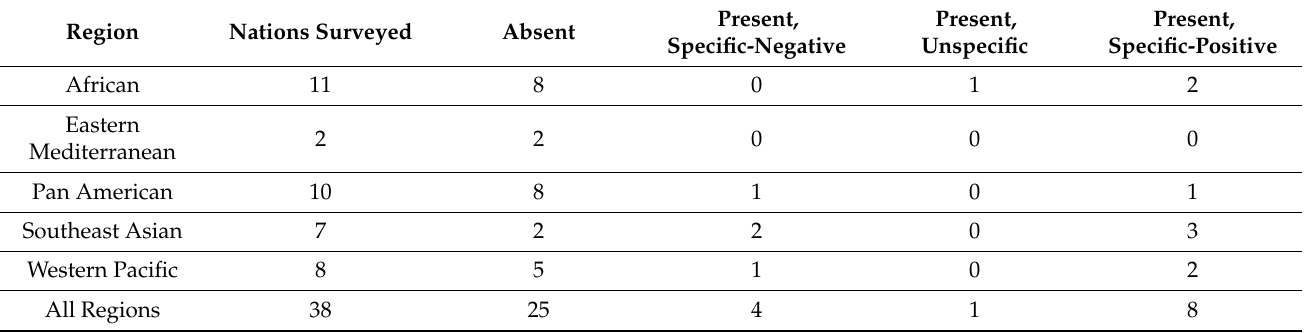
Table 8. Summary of survey